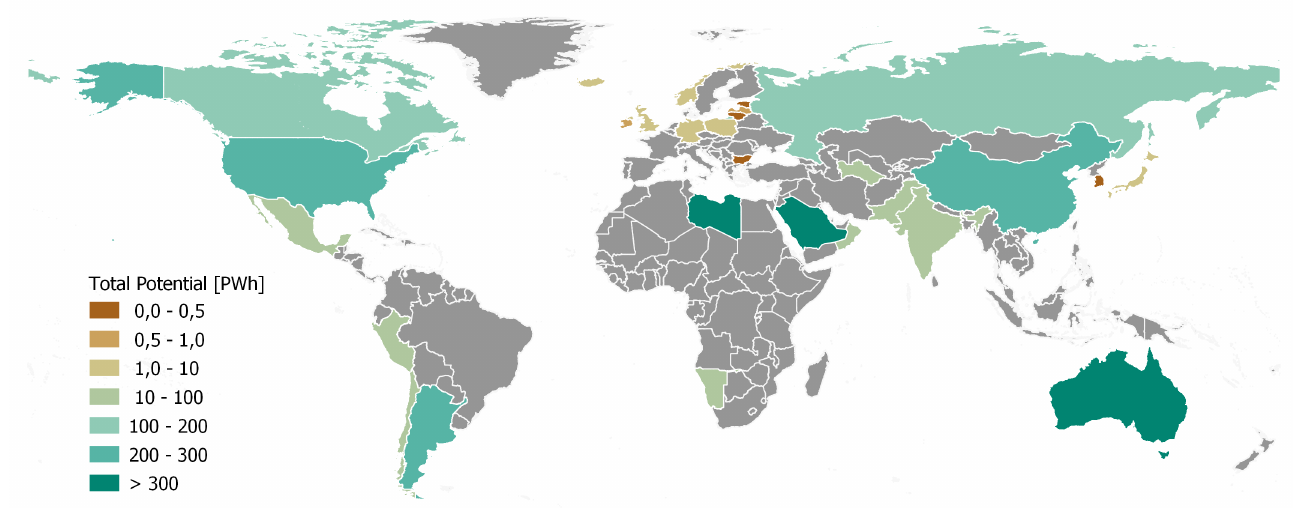
Figure 3. Renewable energy potential (open-field PV, onshore wind,